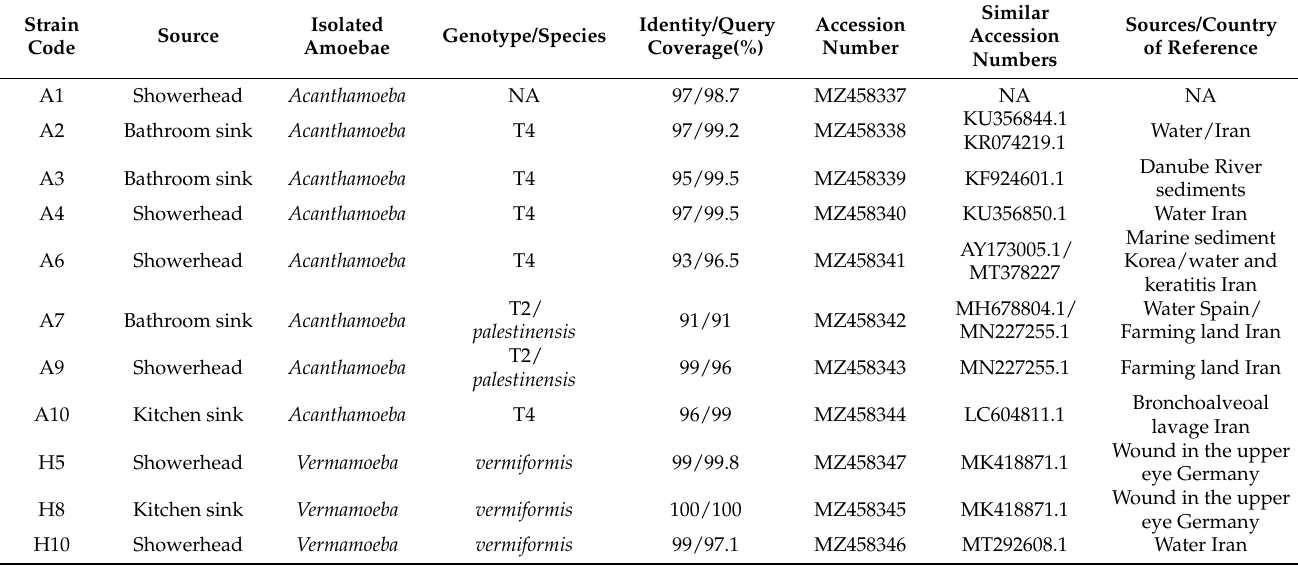
Table 1. Data regarding the positive samples of FLA using molecular identification.